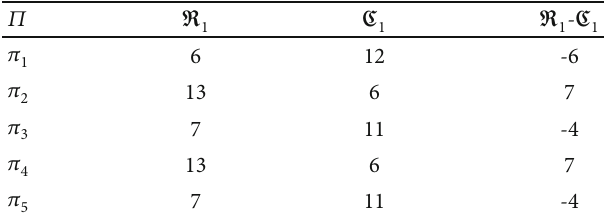
Table 4: The comparison table of Table 1.